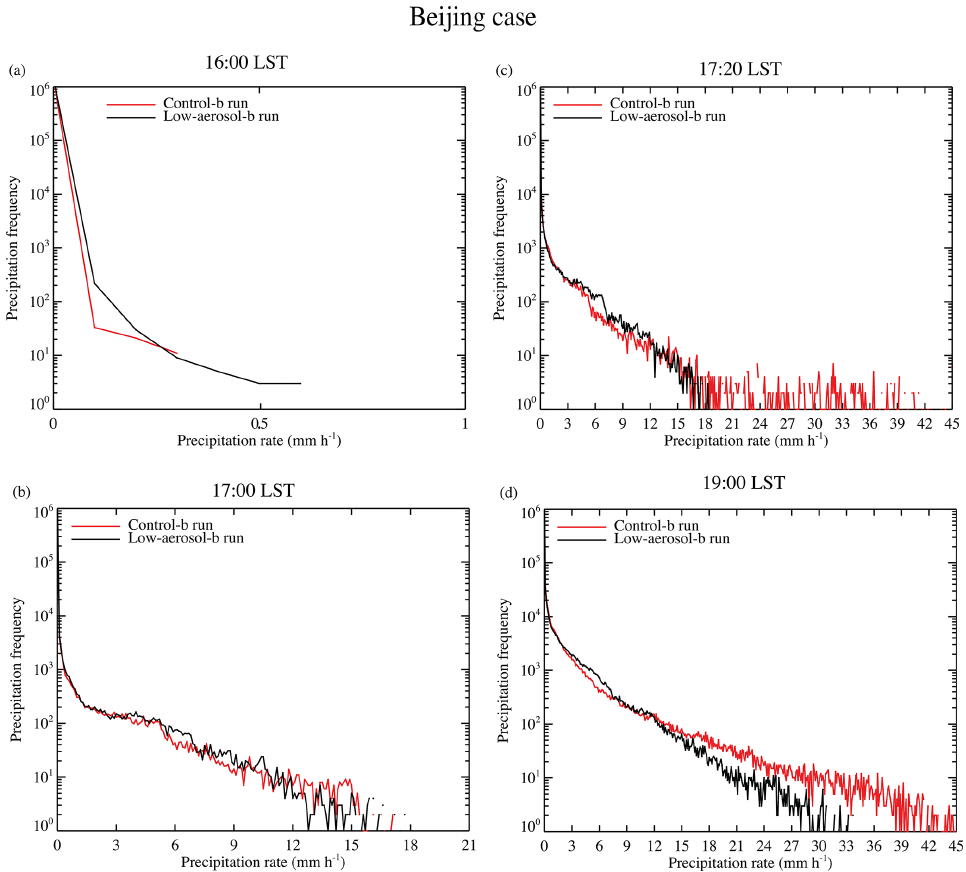
Figure 9. Cumulative frequency distributions of the precipitation rates at the surface in the control-b and low-aerosol-b runs for the Beijing case at (a) 16:00LST, (b) 17:00LST, (c) 17:20LST, and (d) 19:00LST.